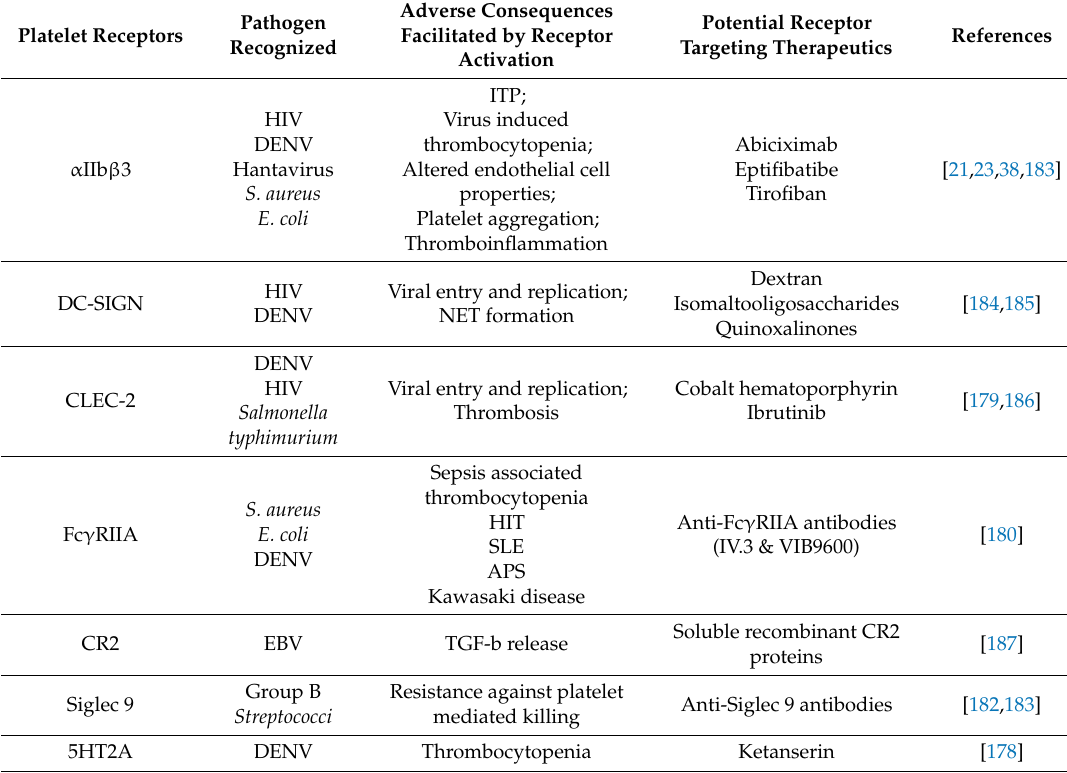
Table 3. Platelet receptors as potential therapeutic targets in infection and